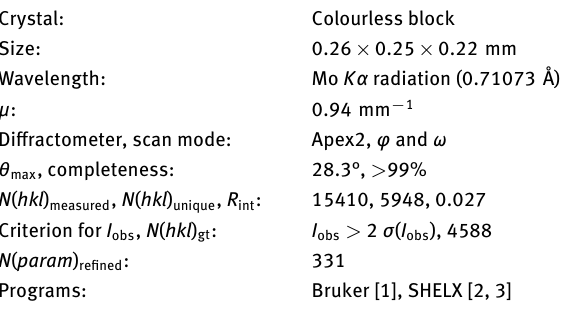
Table 1: Data collection and